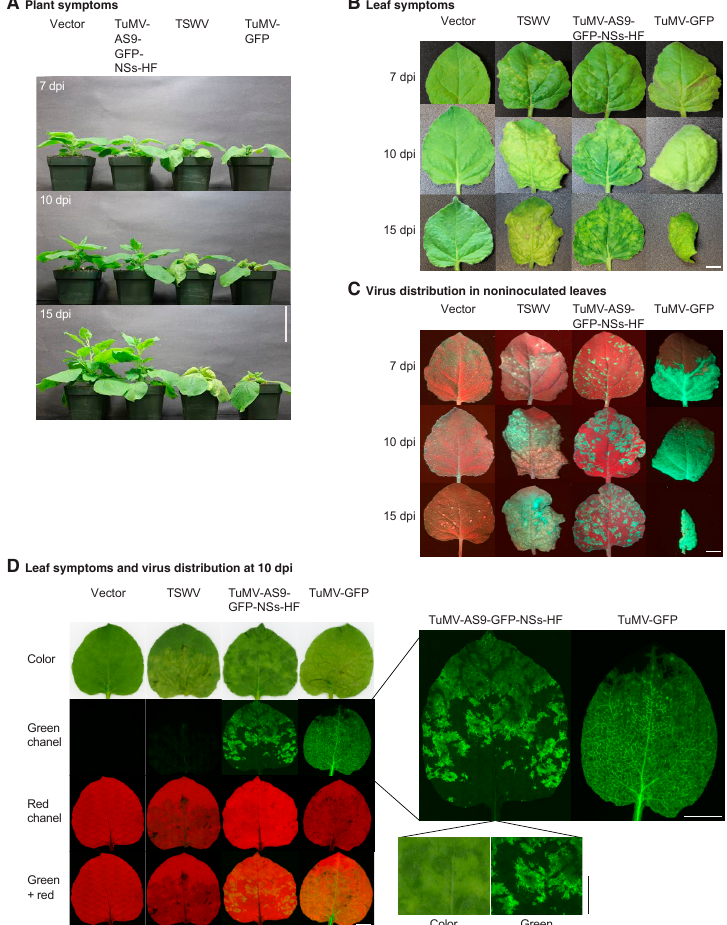
Figure 4. Symptoms and virus distribution in noninoculated leaves of N. benthamiana plants. Plants were inoculated by agroinfiltration with empty vector, TuMV-AS9-GFP-NSs-HF, or TuMV-GFP. TSWV infection was initiated by mechanical inoculation. ( A ) Representative plant symptoms at 7, 10 and 15 dpi. Scale bar: 7.5 cm. ( B ) Photographs showing representative noninoculated leaf symptoms in plants described in ( A ). ( C ) Distribution of virus infection determined by GFP fluorescence under UV light for leaves in ( B ). ( D ) Leaf symptoms and distribution of GFP as determined by confocal microscopy using green and red channels. Leaves infected with TuMV-AS9-GFP-NSs-HF or TuMV-GFP are shown at a larger size to illustrate spatial distribution of virus infection in the leaf. An area of the same size was cropped from the color and green image of the leaf infected by TuMV-AS9-GFP-NSs-HF. Chlorotic areas overlap with virus infection. In ( B – D ), scale bars: 1 cm.